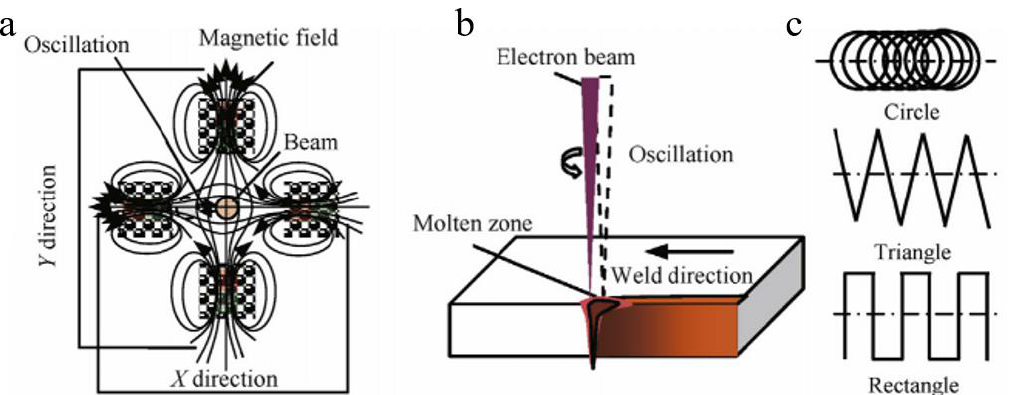
Figure 4. Sketch of EBW with beam oscillation. ( a ) Oscillation with electromagnetic fields. ( b ) Beam oscillating welding. ( c ) Wave function. (Reprinted with permission from ref. [13,14] © (2019) Elsevier, (2019) Elsevier) Table 1. Chemical composition of CLAM steel (wt %).